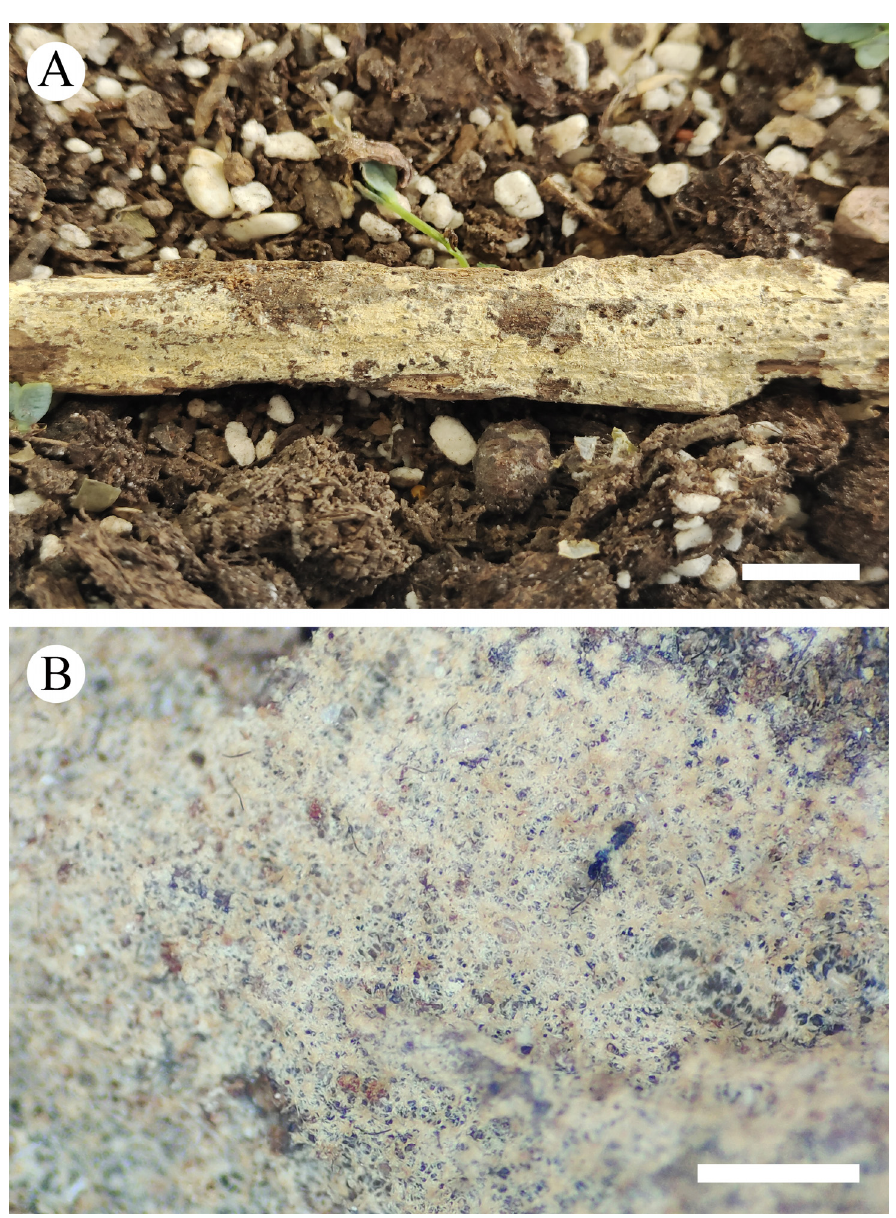
Figure 3. Basidiomata of Xylodon gossypinus (holotype). Bars: a = 1 cm and b = 1